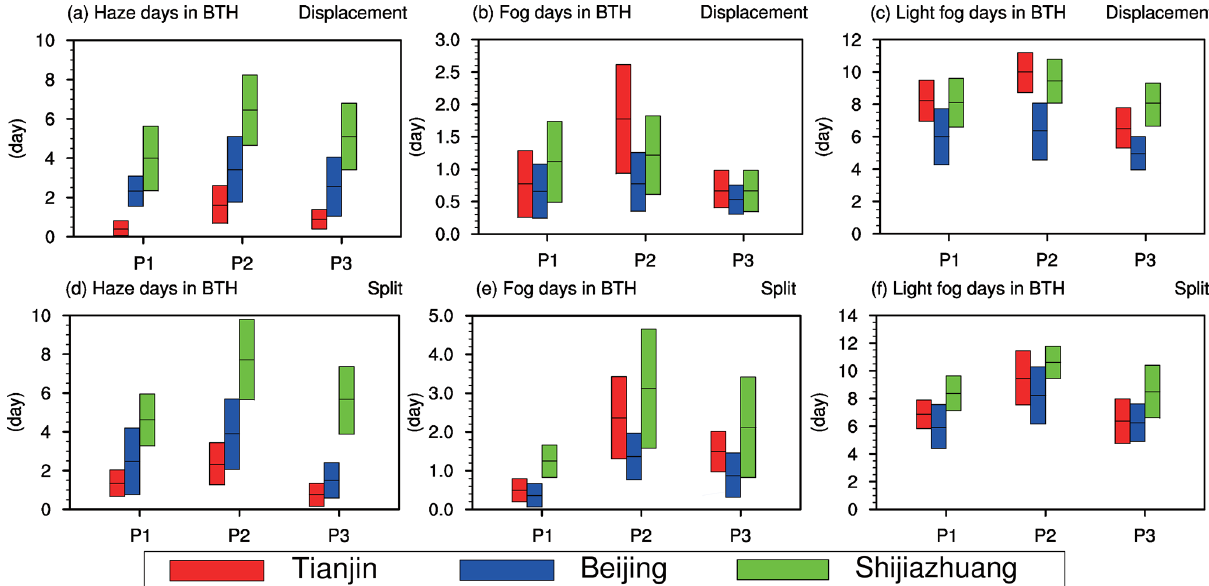
Figure 7. Statistics of three environmental metrics during the three periods of displacement SSWs (a–c) and split SSWs (d–f) . The middle line is the average, and the upper and lower limits are the 95% confidence intervals based on the bootstrap methods by resampling 1000 times. P1 denotes the pre-SSW period from day − 20 to day − 1, P2 denotes the SSW onset period from day 0 to day 20, and P3 denotes the SSW decaying period from day 21 to day 40. Composite means in three cities are shown for mean numbers of (a, d) haze days, (b, e) fog days (visibility < 1km), and (c, f) light fog days (visibility <